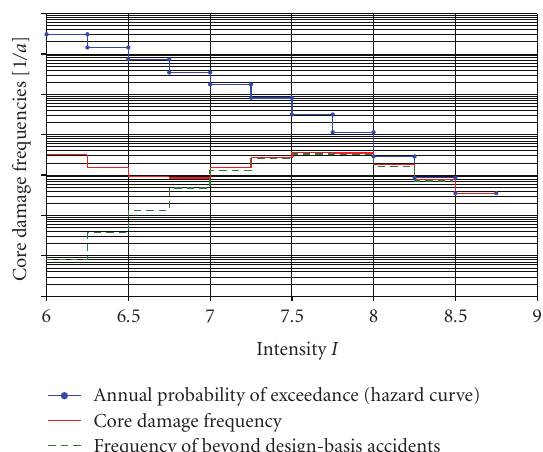
Figure 5: Core damage frequencies for di ff erent intensity inter- vals. For comparison the corresponding annual probability of exceedance and the fraction of seismic-induced beyond design-basis accidents are shown. Values on the y -axis are omitted